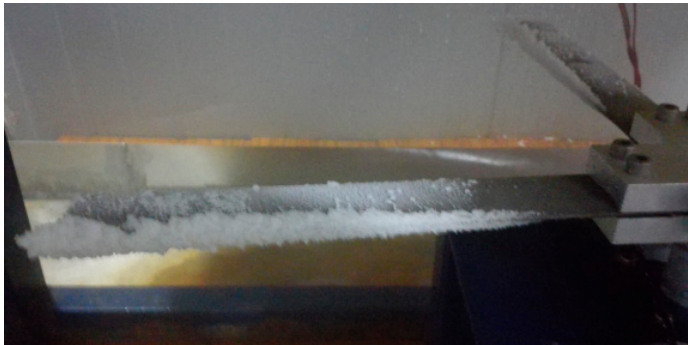
Figure 6. Ice shape of rotor blade.